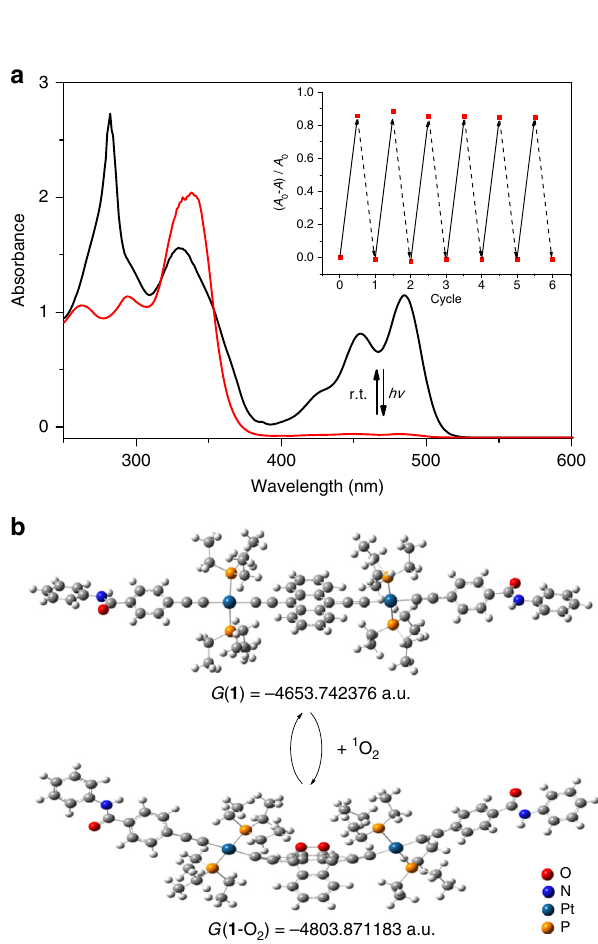
Fig. 4 Experimental and theoretical studies for photo-switching. a UV – Vis spectra change of 1 (2.00 × 10 − 4 M in CHCl 3 ) upon the successive 460 nm light irradiation and standing at room temperature. Inset: multicycle tests by monitoring the absorbance changes at 484 nm. b Optimized structures and the Gibbs-free energy of 1 and 1 -O 2 on the basis of DFT